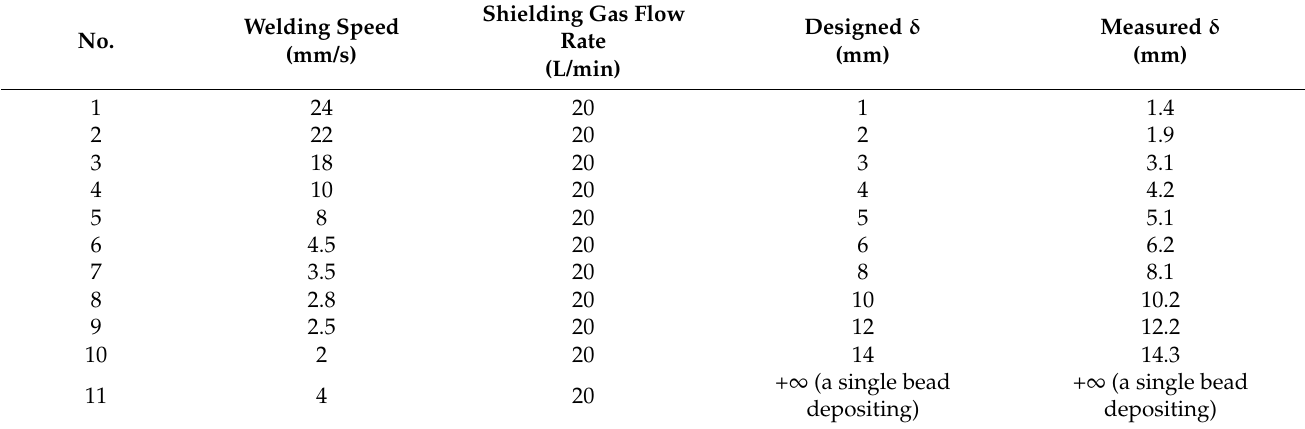
Table 1. Deposition parameters.